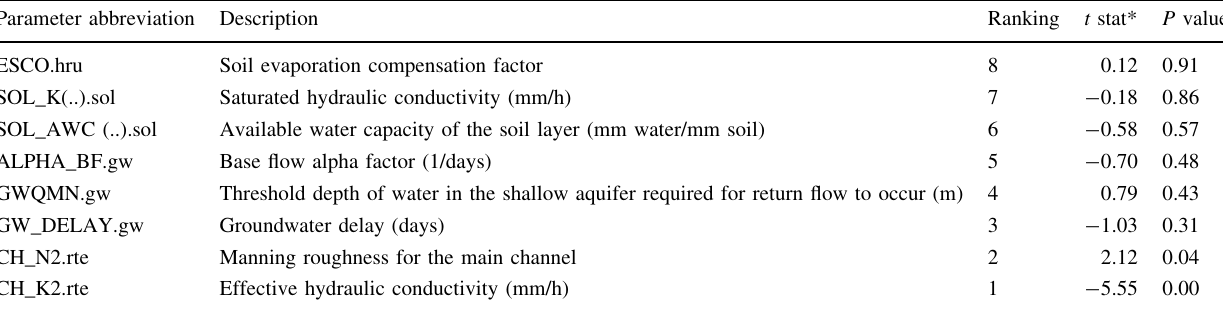
Table 2 Parameter sensitivities for SUFI-2